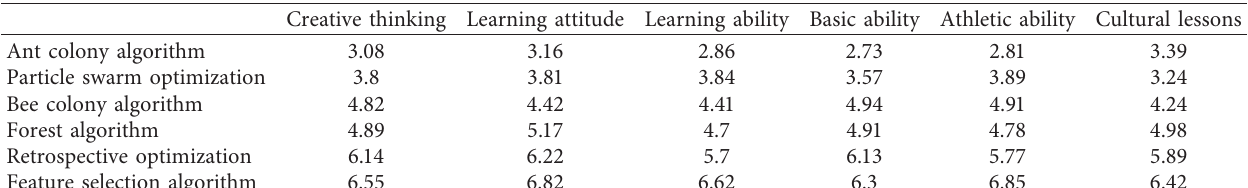
Figure 5: Changes of male students after teaching. Table 4: Female students after algorithm teaching.